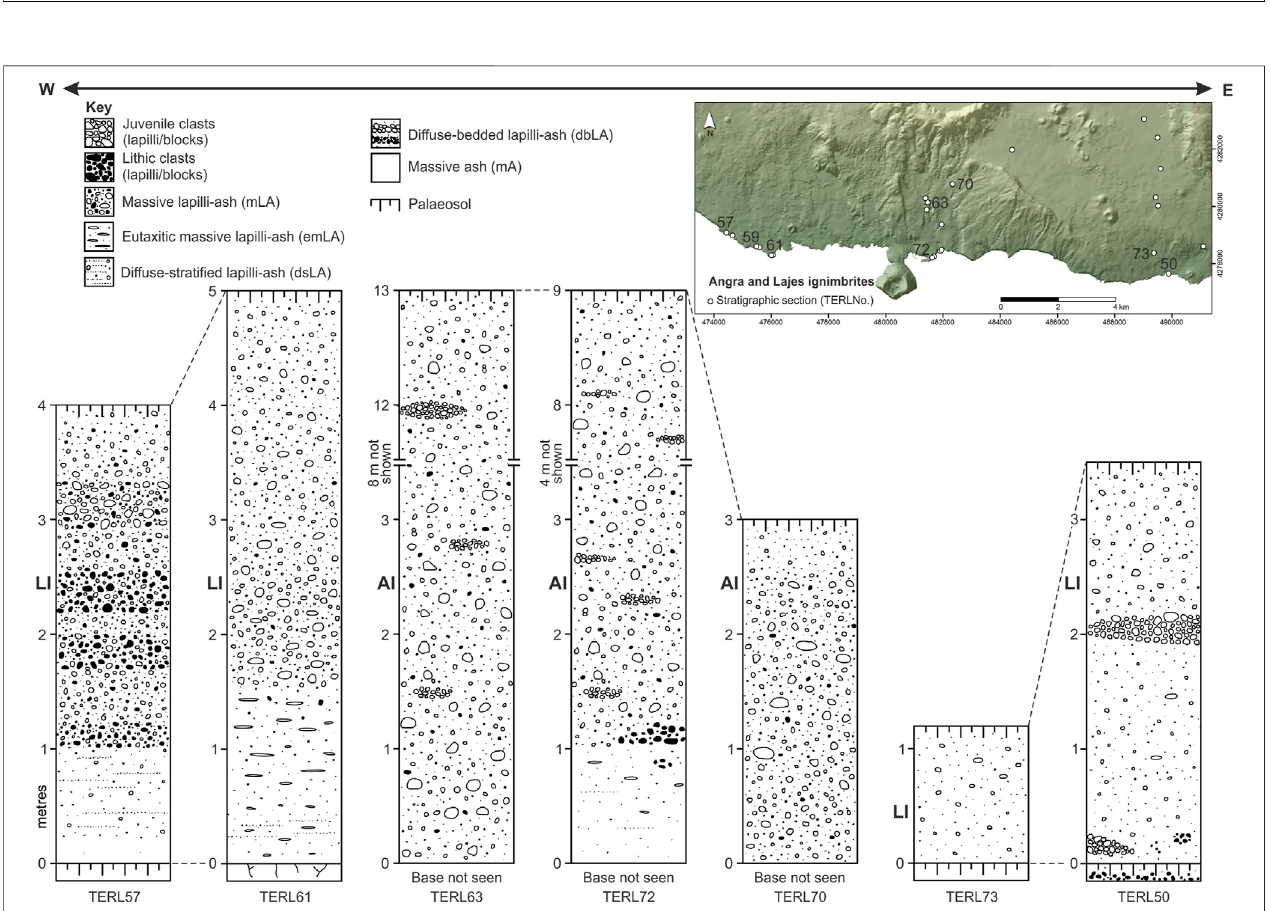
FIGURE7| Representativestratigraphic sectionsoftheAngraand Lajesignimbritesalongthesouthcoast ofTerceira.AI — AngraIgnimbrite.;LI — LajesIgnimbrite.